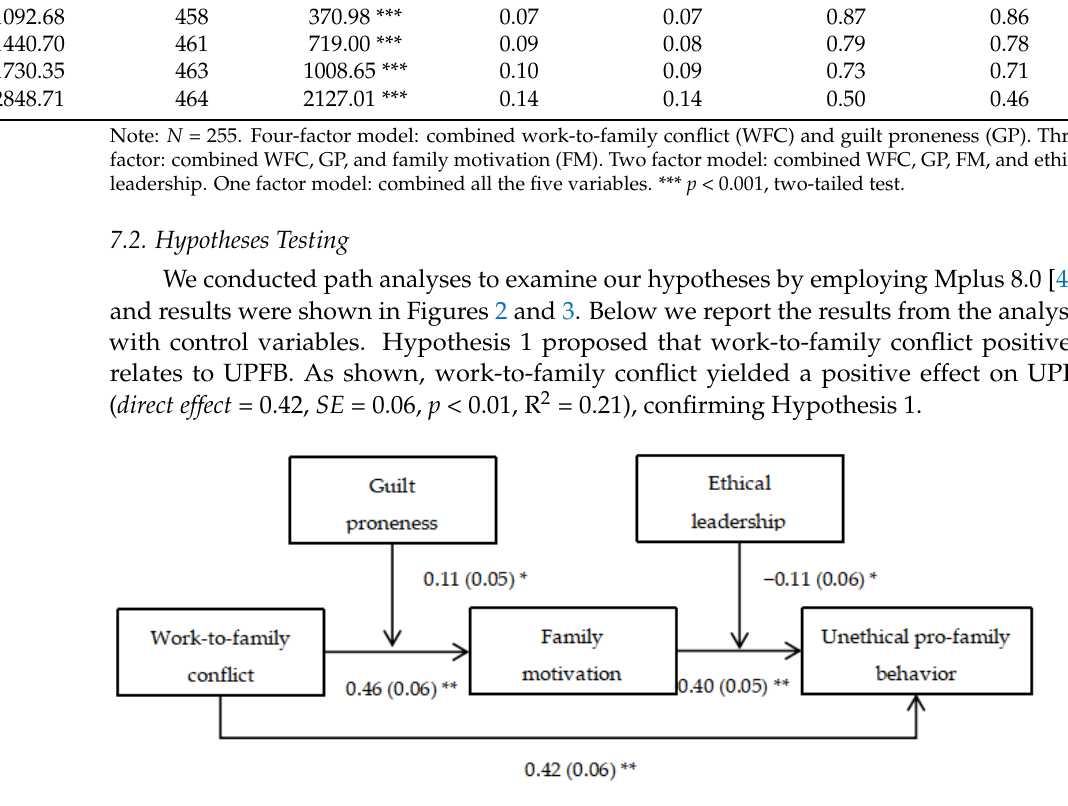
Figure 2. Unstandardized Estimates of Path Analyses. Note: N = 255. For brevity, we did not present the coefficients of the control variables (i.e., gender, age, education, tenure, marital status, and the number of children). * p < 0.05, ** p < 0.01, two-tailed test.